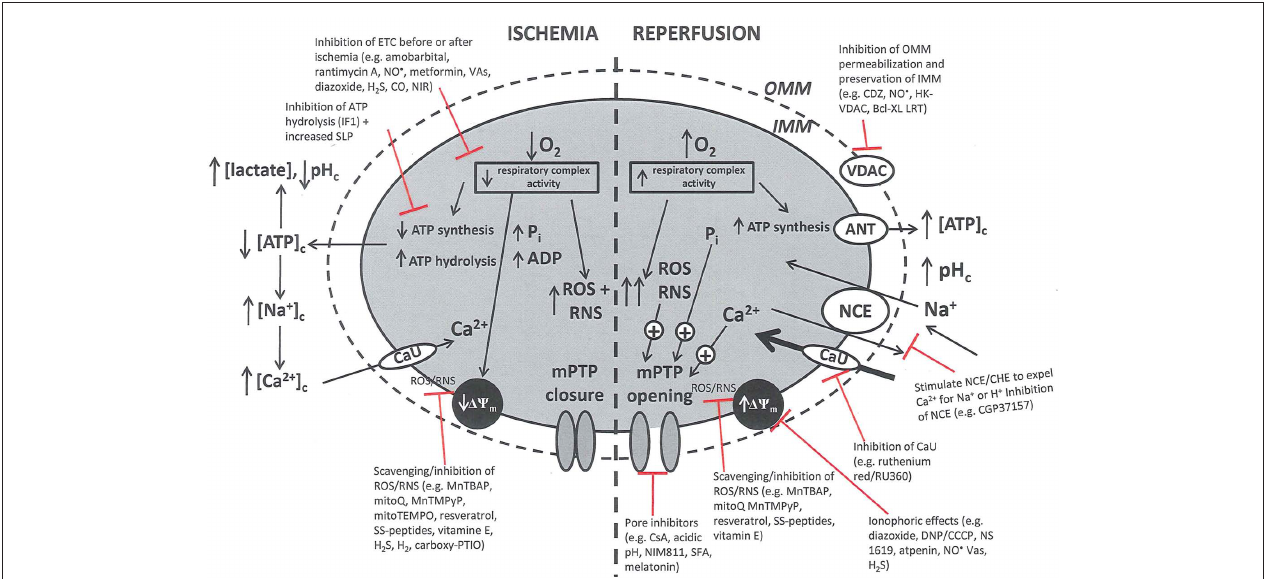
Figure 3 | Simplified schema of changes in cytosolic and mitochondrial species; RNS, reactive nitrogen species; mPTP, membrane permeability function during cardiac i/r injury and site of mitochondrial-targeted transition pore; ANT, adenine nucleotide translocator; VDAC, voltage dependent therapies with potential to reduce mitochondrial and cell damage. Targets anion channel. Compounds: VAs, volatile anesthetics; CDZ, chlorodiazepine; HK, are (a) the outer mitochondrial membrane (OMN), (e.g., putative mPTP hexokinase; CGP, CGP37175: DNP, dinitrophenol; MnTBAP, Mn(II)tetrakis(4- components VDAC, ANT, etc.); (b) the inner mitochondrial membrane (IMM), benzoate) porphyrin chlorine; CsA, cyclosporin A; NIM811, N -methyl-4- [e.g., ANT, Ca 2 + uniporter (CaU), Na + /Ca 2 + exchanger (NCE), Ca 2 + /H + exchanger isoleucine-cyclosporin; SS, Sezto–Schiller tetrapeptides; SFA, sanglifehrin; LRT, (CHE)]; (c) the membrane potential ( ∆Ψ ); (d) electron transport (complexes I–V); lipid replacement therapy; CCCP, carbonyl cyanide p-(trifluoromethoxy) m and (e) ATP synthesis/hydrolysis (complex V). Abbreviations: ETC, electron phenylhydrazine, MnTMPyP, Mn(III)tetrakis[(1-methyl-4-pyridyl)-porphyrin]; transport chain; SLP, substrate level phosphorylation; ROS, reactive oxygen